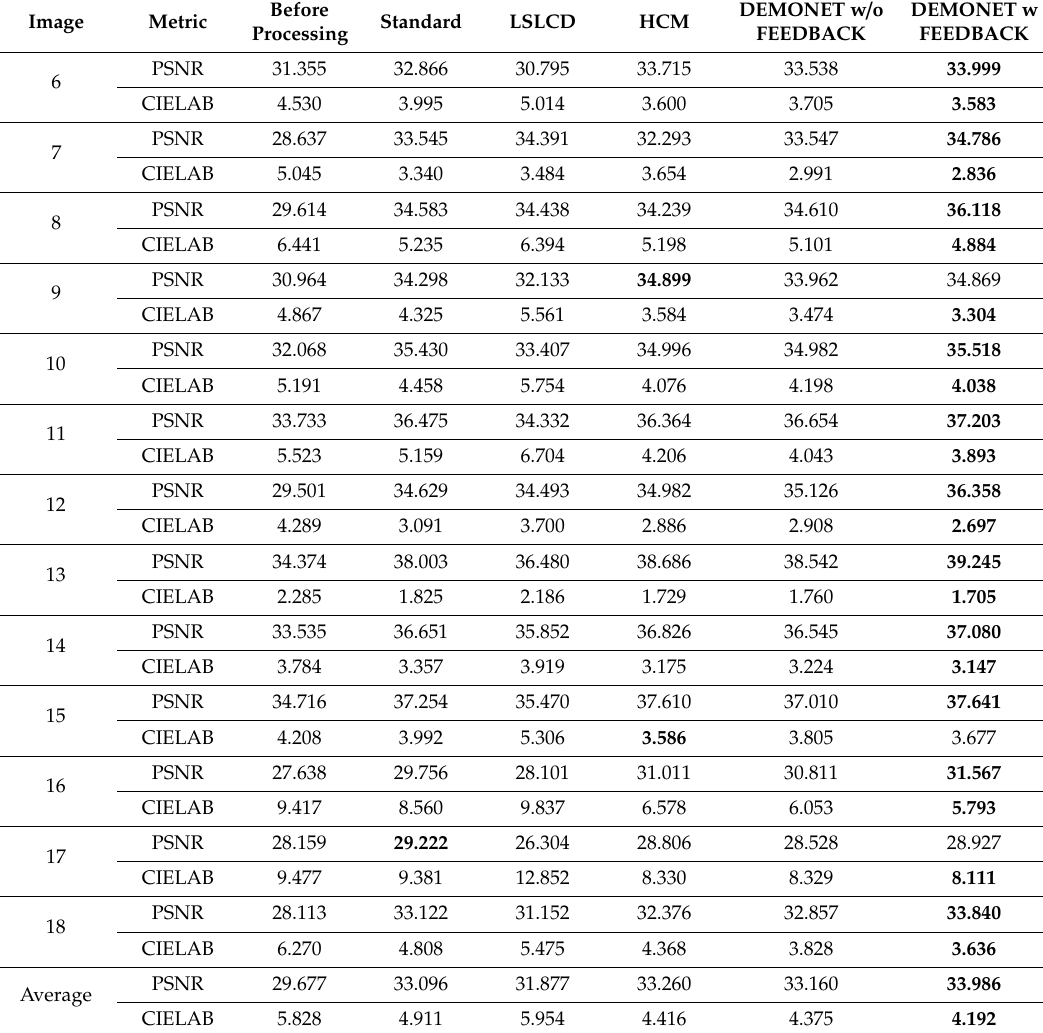
Figure 11. Averaged CIELAB values of different methods. Before Processing